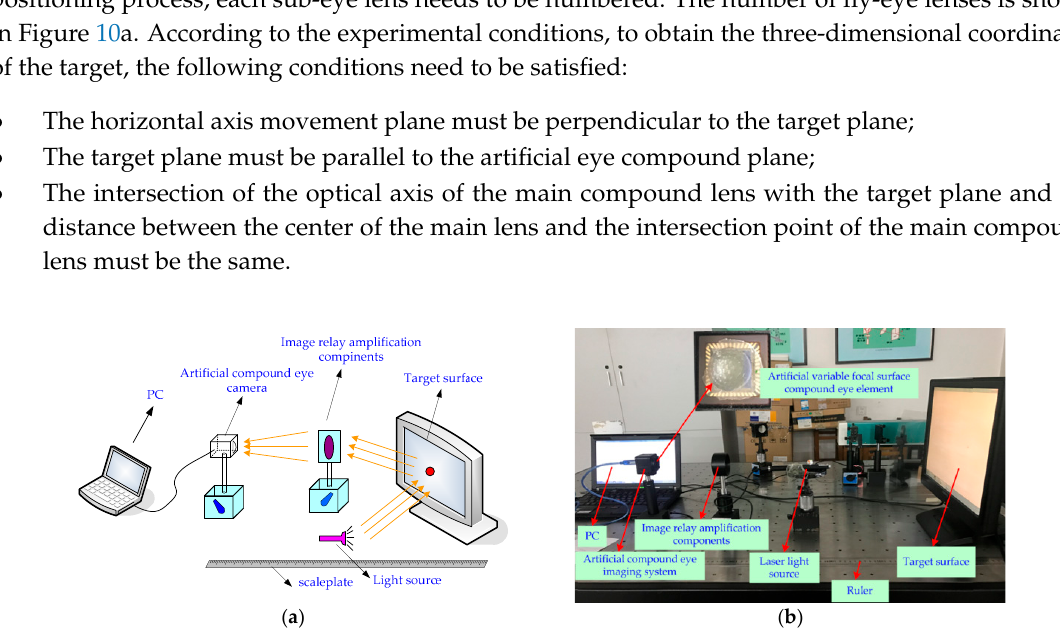
Figure 9. Multi-eye positioning experiment with an artificial compound eye: ( a ) schematic, and the light source illuminates the target surface to form a target image, and the compound eye camera captures the target image on the target surface; ( b ) photograph of test bench.